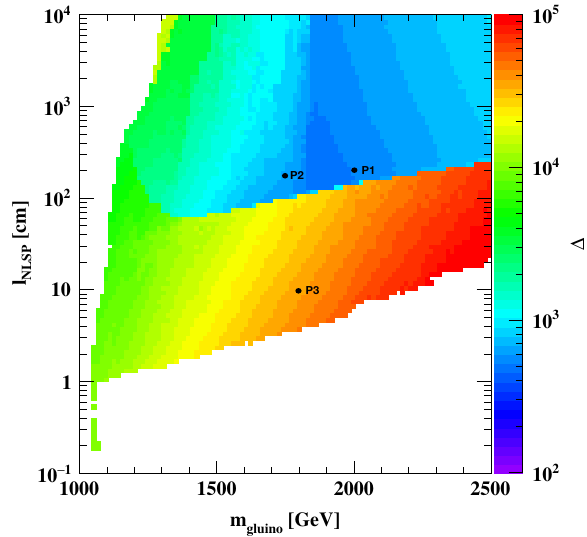
Fig. 2 The same as in Fig. 1 but for the U model and without applying constraintsfromLHCsparticlesearches.Alsoshownarethebenchmark points P1–P3 of Table